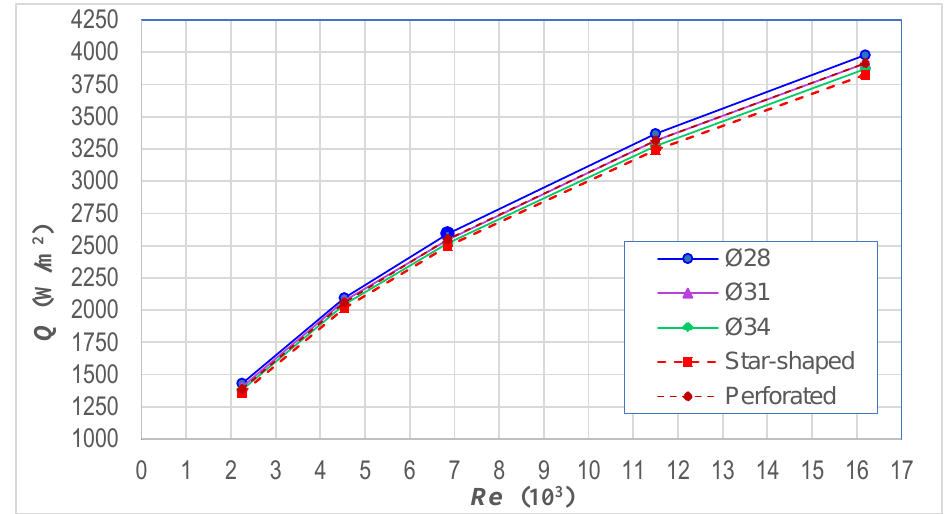
Figure 15. Heat flux versus Re number.